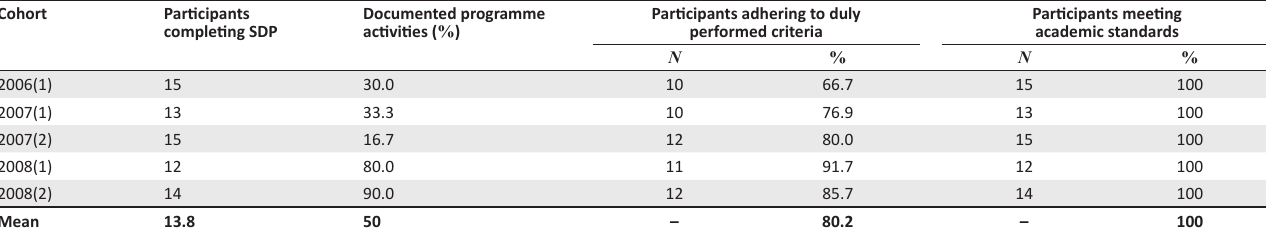
TABLE 2: Adherence to stated performance standards for participants completing the supervisory development programme from 2006 to 2008. Cohort Participants completing